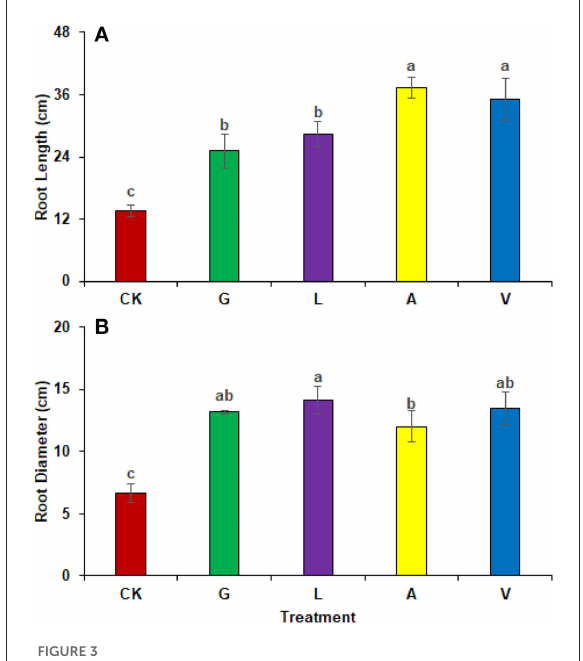
FIGURE3 Biometric attributes of radish: (A) Root length (B) Root diameter observed in experiment 1 using chemical fertilizer (CK), glycine (G), lysine (L), aspartic acid (A), and vitamin B complex (V). The values mentioned herein are indicated as mean ± S.D and the lowercase letters indicate the significant difference among the means.